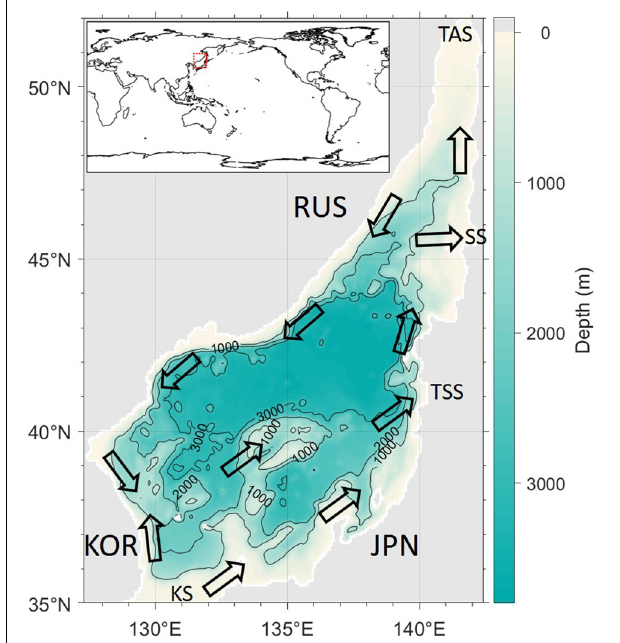
FIGURE 1 | Map of the East Sea (ES; Sea of Japan). Open arrows represent major surface currents. The iso-depth interval is 1,000 m and land is shaded in light gray. KOR, RUS, and JPN indicate Korea, Russia, and Japan, respectively. KS, TSS, SS, and TAS denote Korea/Tsushima, Tsugaru, Soya, and Tatarsky straits, respectively. The ES is represented by a red dotted rectangle on the world map (upper left). Latitudinal sections in Figures 2–9 are zonally integrated sections in the ES because the ES MOC was calculated with zonally integrated